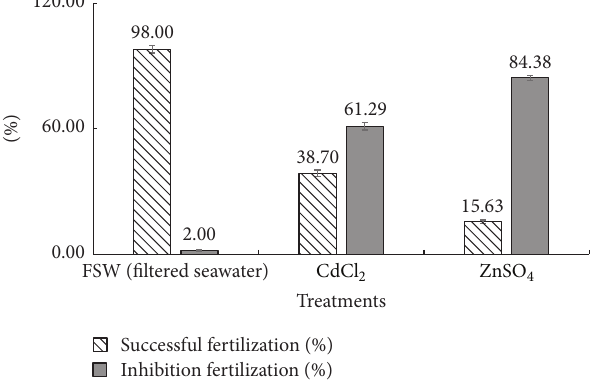
Figure 3: The percent successful fertilization and inhibition of fertilization as observed on the gametes after 30 mins exposure to 1 × 10 −3 M CdCl 2 , 1 × 10 −4 M ZnSO 4 and filtered seawater.